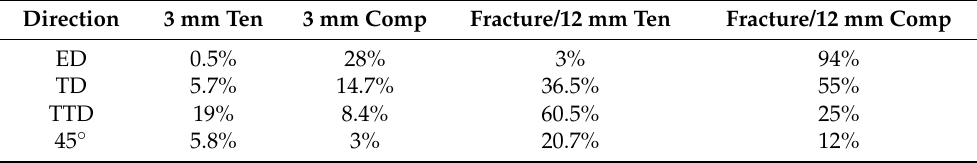
Table 1. Volume fraction of matrix that has been reoriented by tensile twinning.